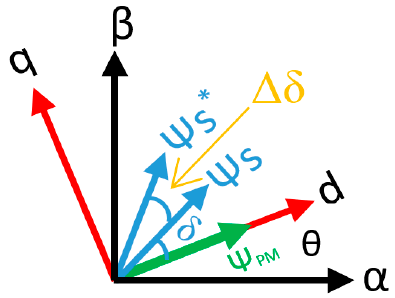
Figure 3. Stator and rotor field orientations in dq axis.